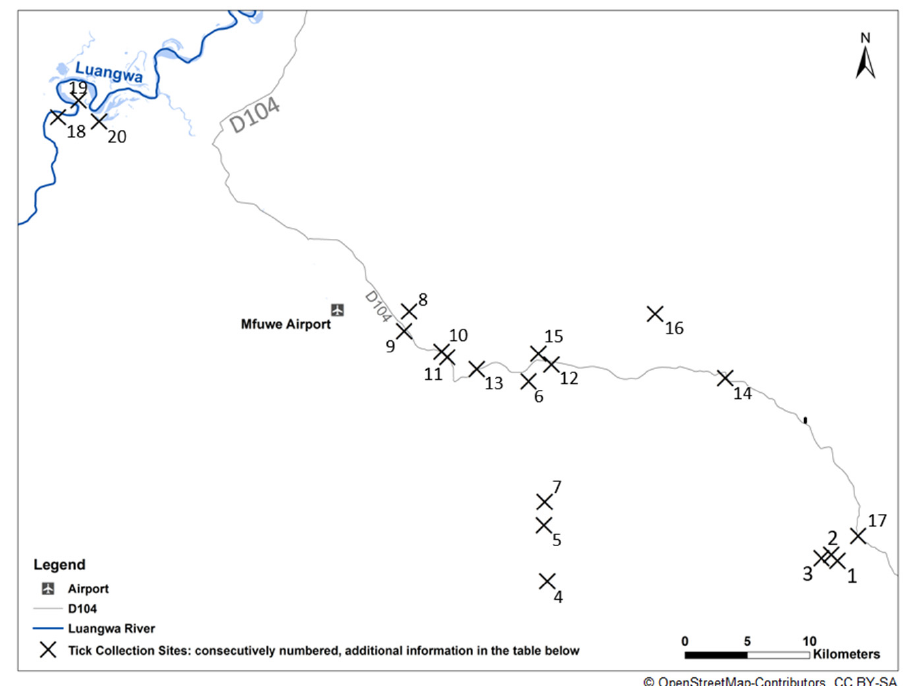
Figure 1. Map of locations of tick collection. Legend: Kakumbi: No. 18, 19, 20; Chikowa: No. 5, 7; Jumbe: No. 8–13, 15, 16; Mphomwa: No. 1–4. 6, 14, 17; The map was designed in ArcGIS